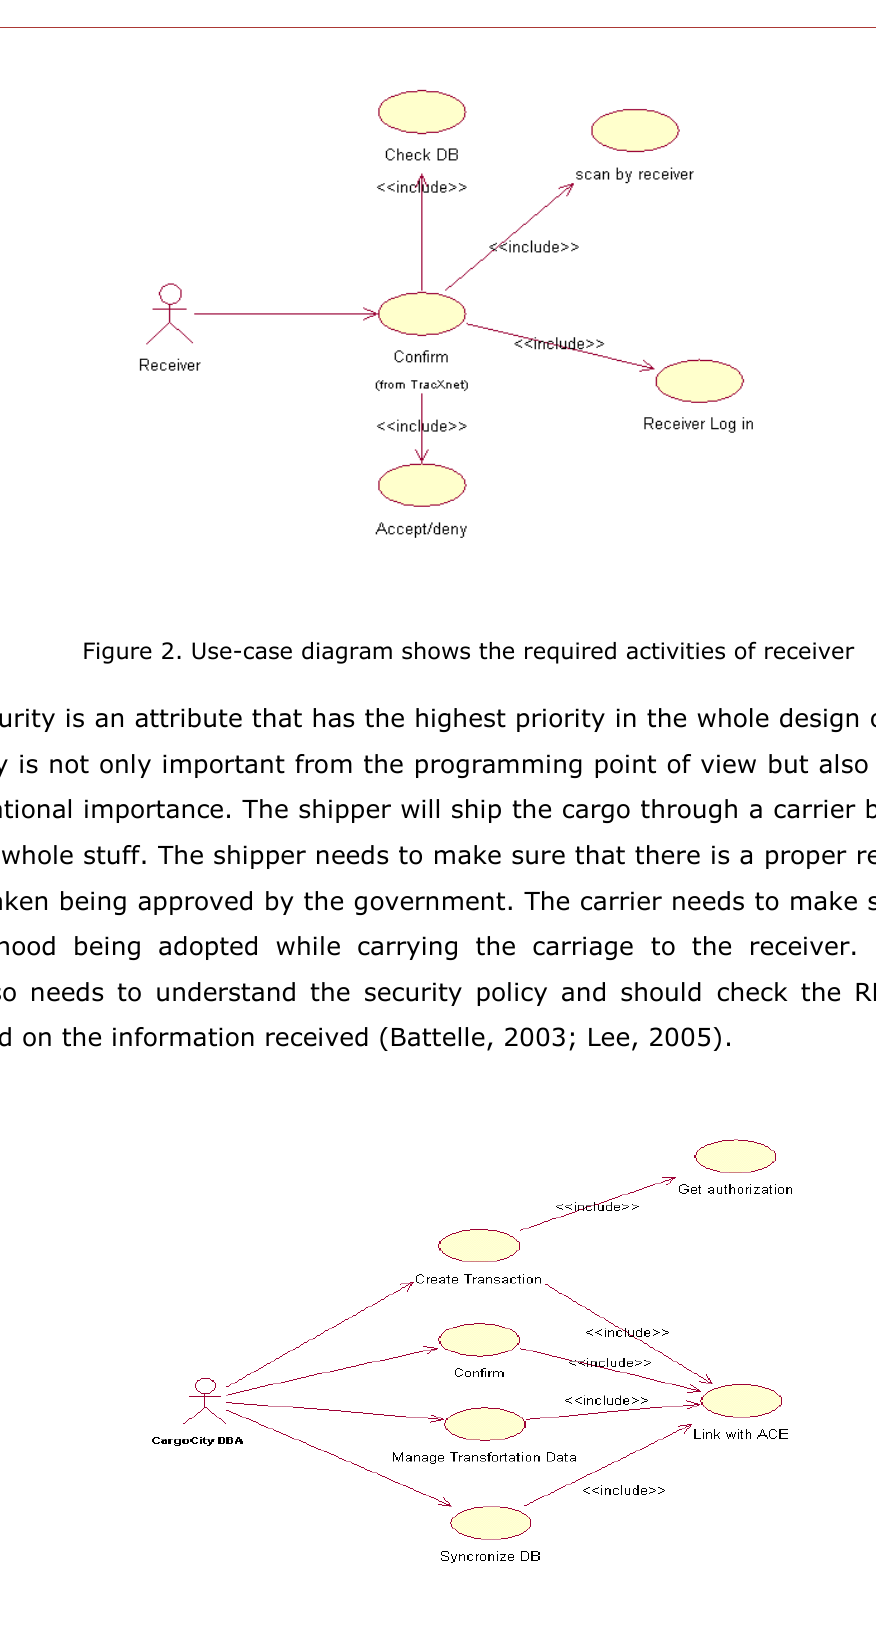
Figure 3. Use-case diagram shows the required activities of database administrator